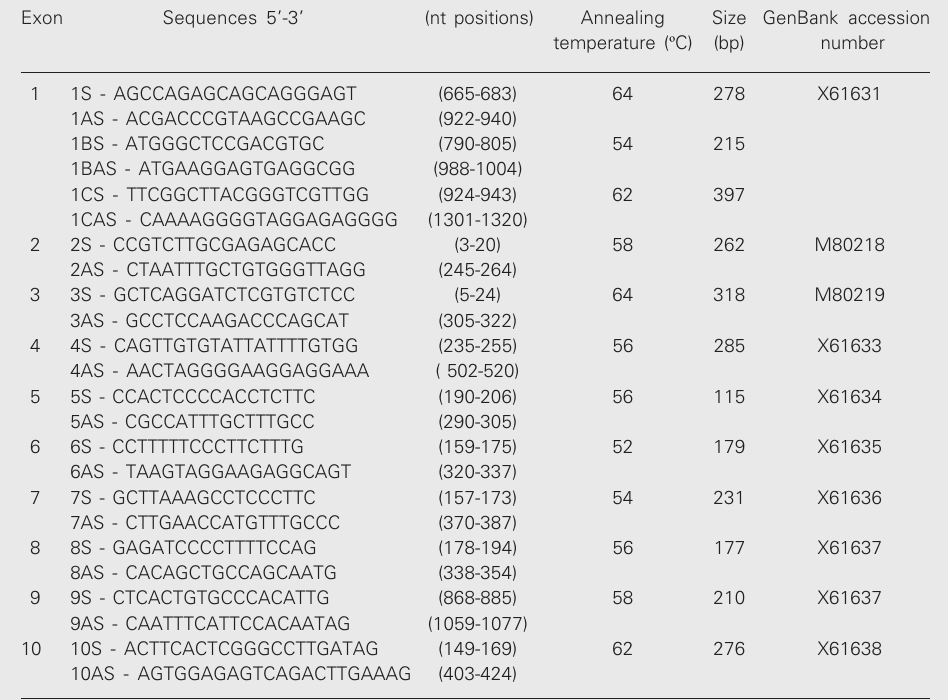
Table 2. Primers designed for WT1